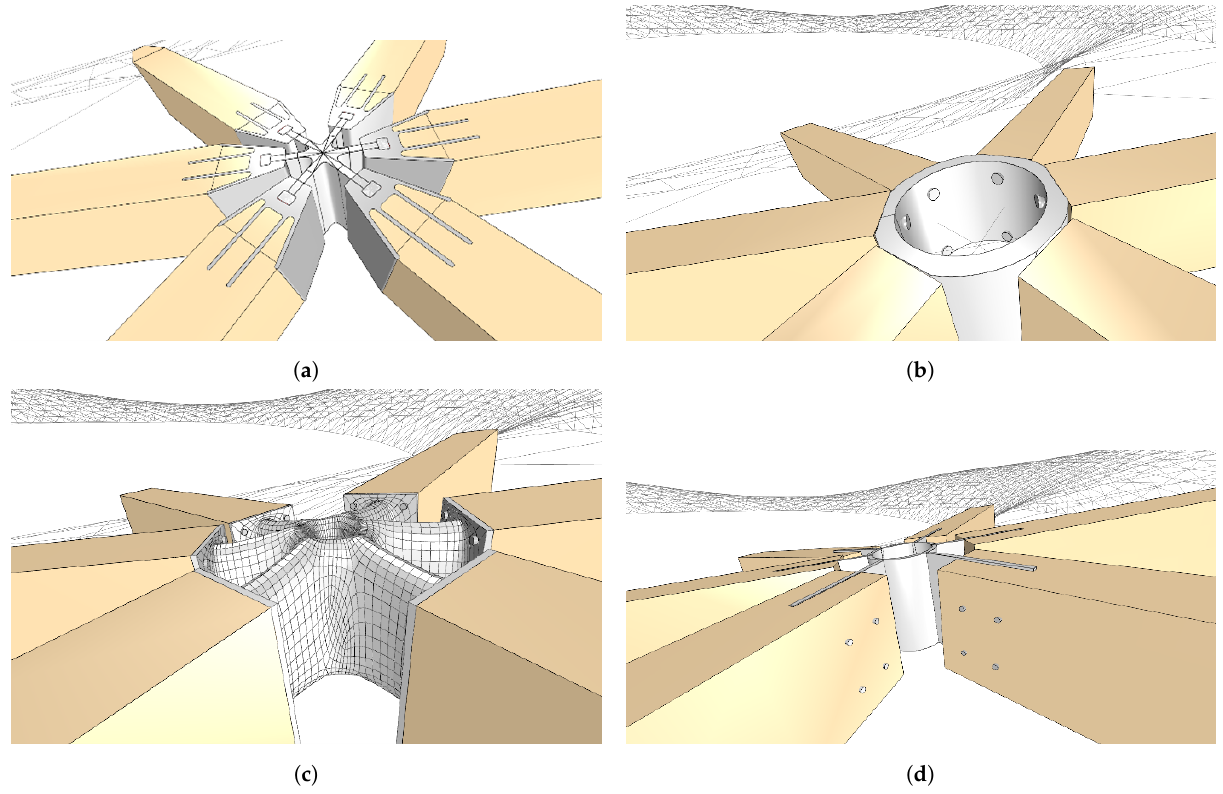
Figure 10. The four node geometries that will be evaluated using this section’s proposed workflow. ( a ) Illustration of the Glued Finger Node. ( b ) Illustration of the Mero ZK. ( c ) Illustration of the Starnode. ( d ) Illustration of the